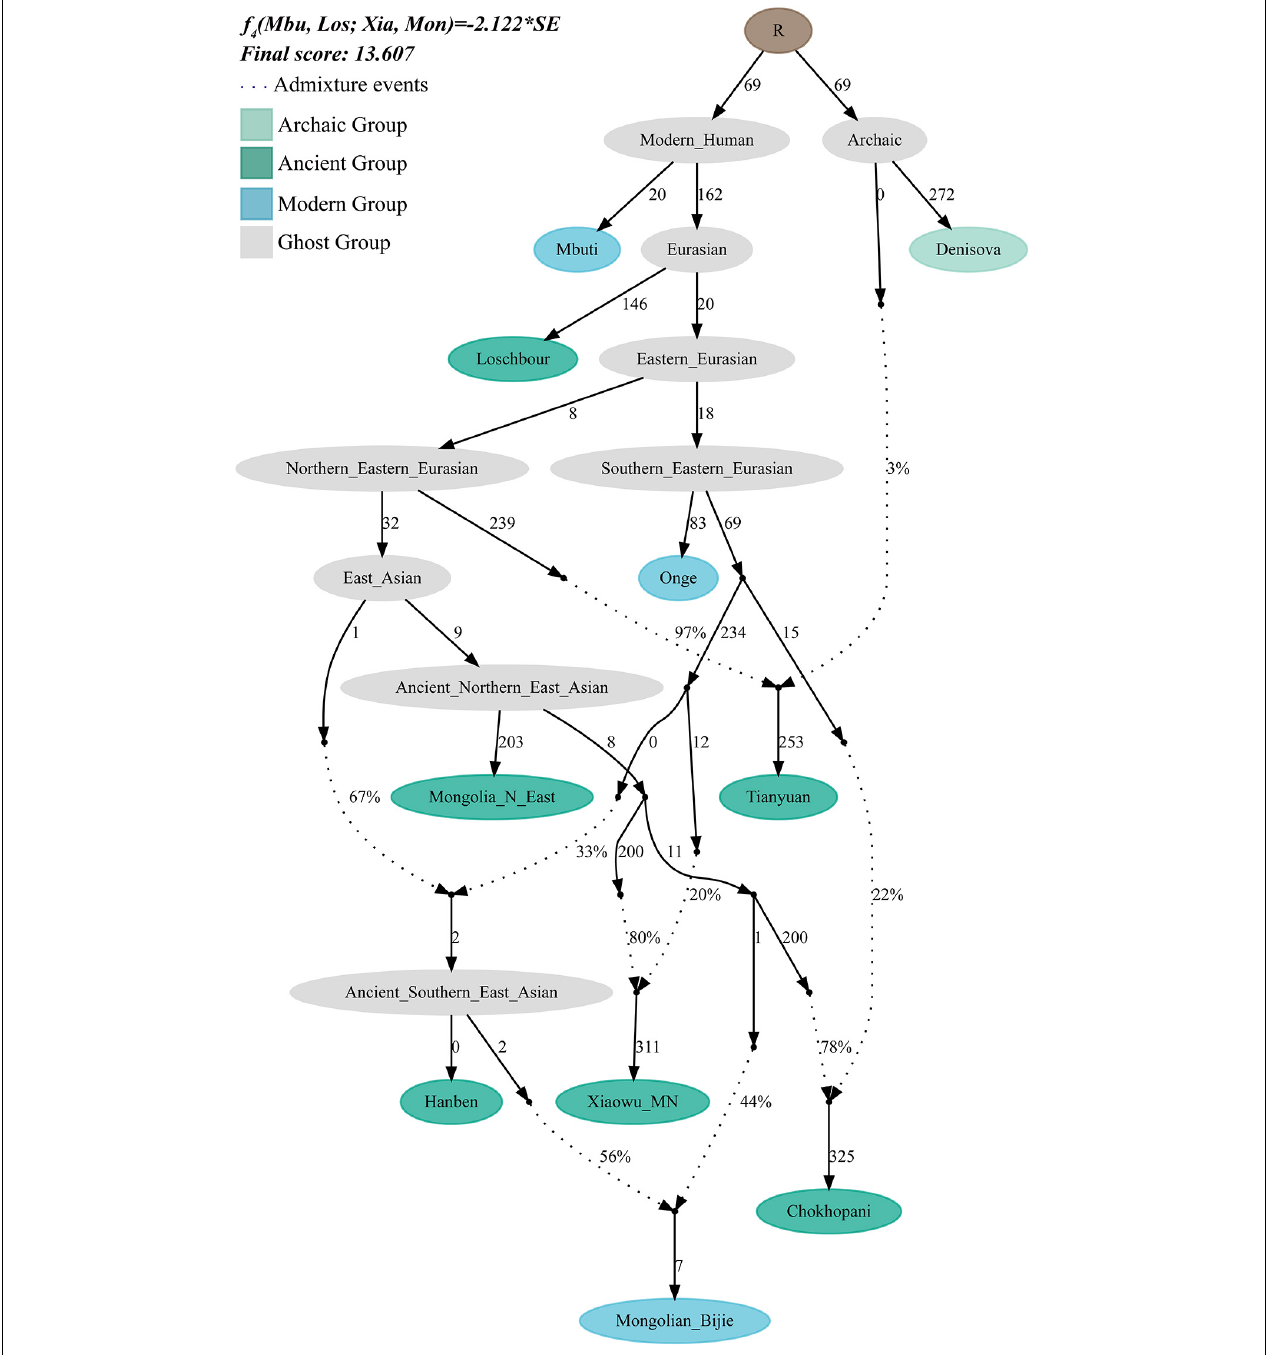
FIGURE 5 | The suggested admixture model of southern Mongolian people via qpGraph . The merged 1240K dataset was used. Dotted line denotes the admixture events, and their corresponding admixture proportions also marked. One hundred times of genetic drift ( f 2 values) were denoted. Ancient populations, modern targeted, and ghost populations were